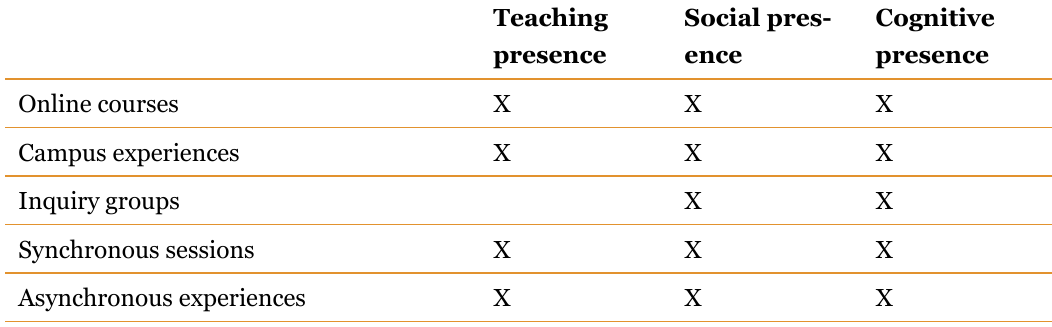
Table 1 Key Program Features Mapped to CoI